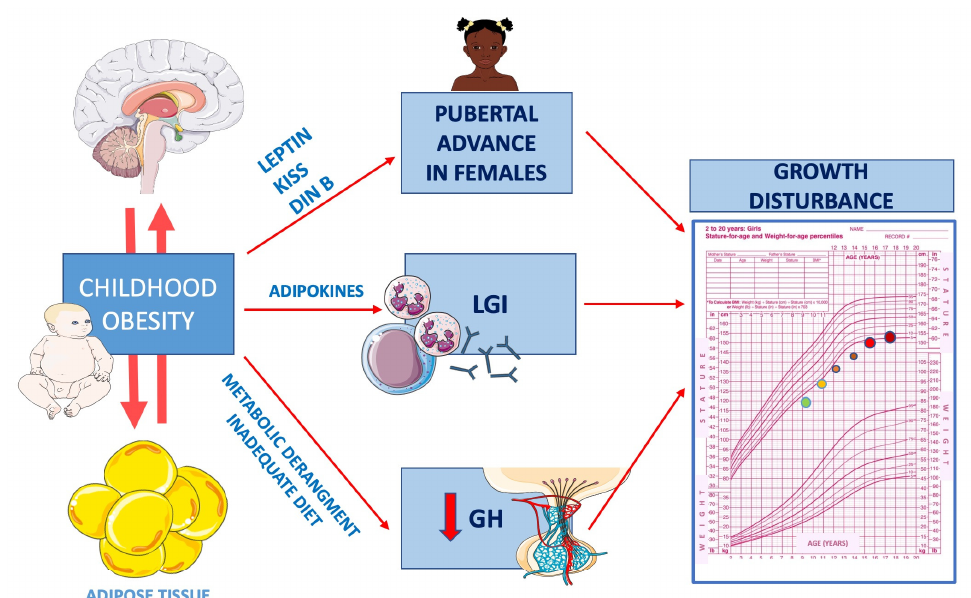
Figure 2. Mechanisms related to impaired growth in obese children. As explained in the text, child- hood obesity influences growth and puberty acting via different mechanisms. Precocious activation of the leptin–kisspeptin axis is responsible for early-onset puberty, especially in female adolescents. Obese children present growth hormone hyposecretion. Systemic low-grade inflammation is also involved. GH: growth hormone; LGI: low-grade inflammation; KISS: kisspeptin; DIN B: dynorphin